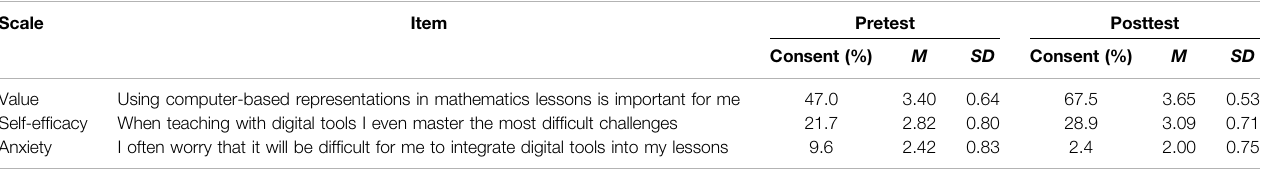
TABLE 1 | Teachers consent with statements in generic items of the three scales value, self-ef fi cacy, and anxiety. Scale Item